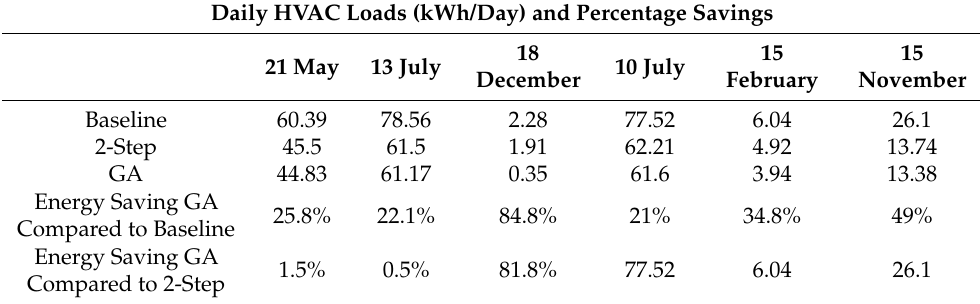
Table 8. HVAC loads for baseline windows and optimized STIS–smart windows applied to a house located in Phoenix, AZ, USA for six representative days using two control strategies.